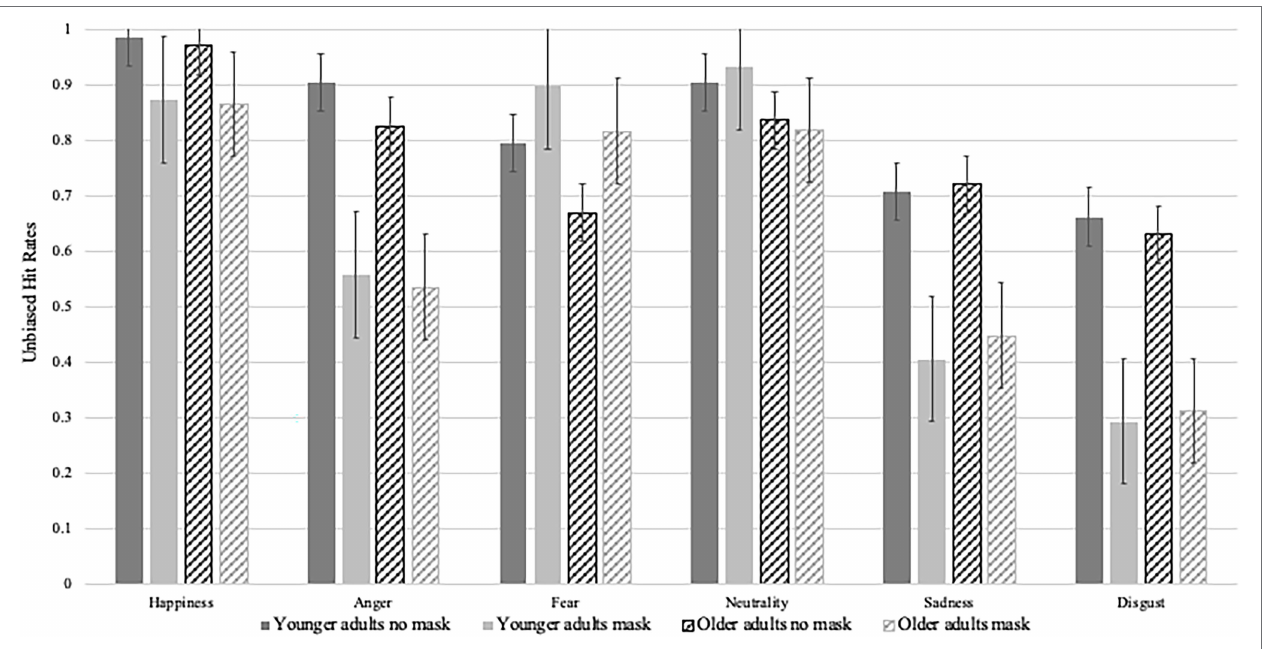
FIGURE 4 | Emotion recognition performance per emotion, mask condition and age